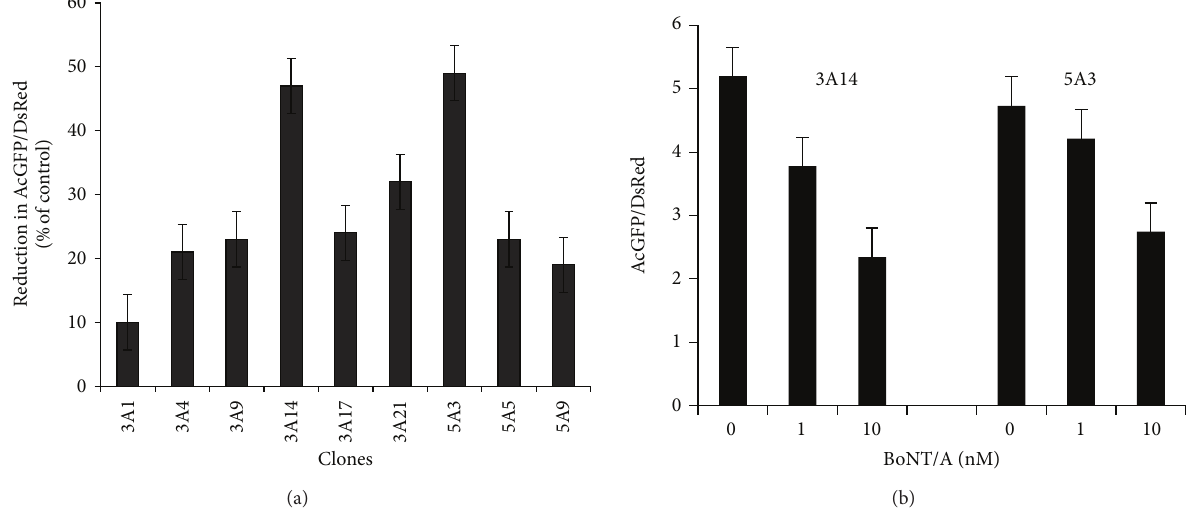
Figure 2: (a) Clone selection and passage stability of different clones. More than 20 clones isolated for the expression of the reporter.